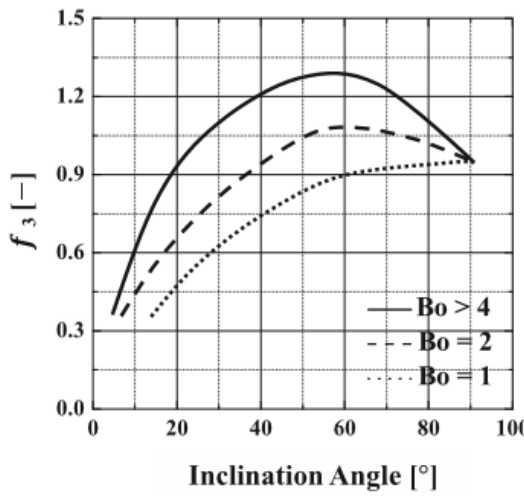
Figure A2. Variation of factor f 3 with the inclination angle β and the Bond number [27,28].